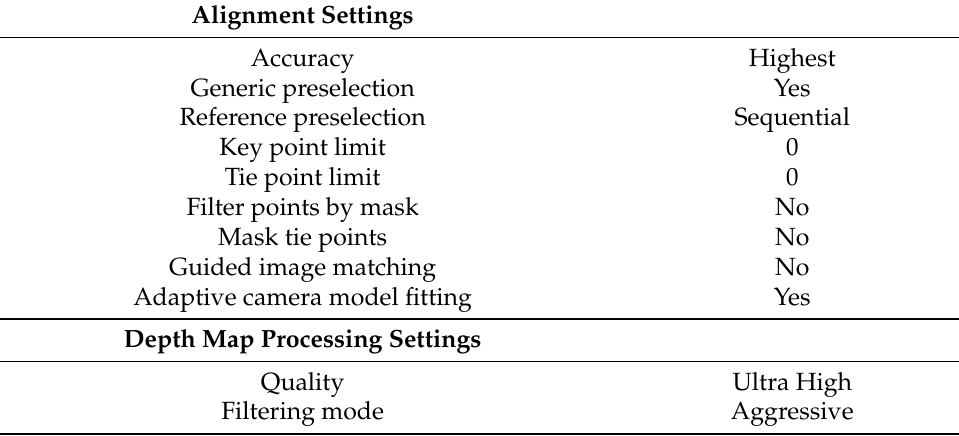
Table 5. Agisoft Metashape image alignment and processing